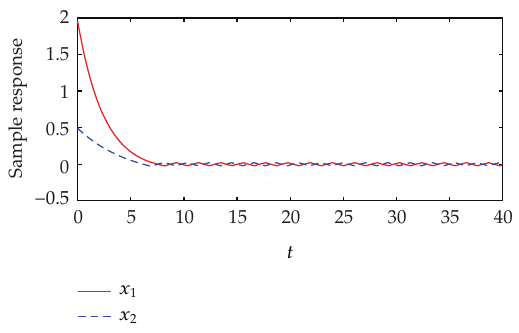
Figure 5: Sample response of PWM feedback system (cid:2) 3.6 (cid:3) in Example 4.2.